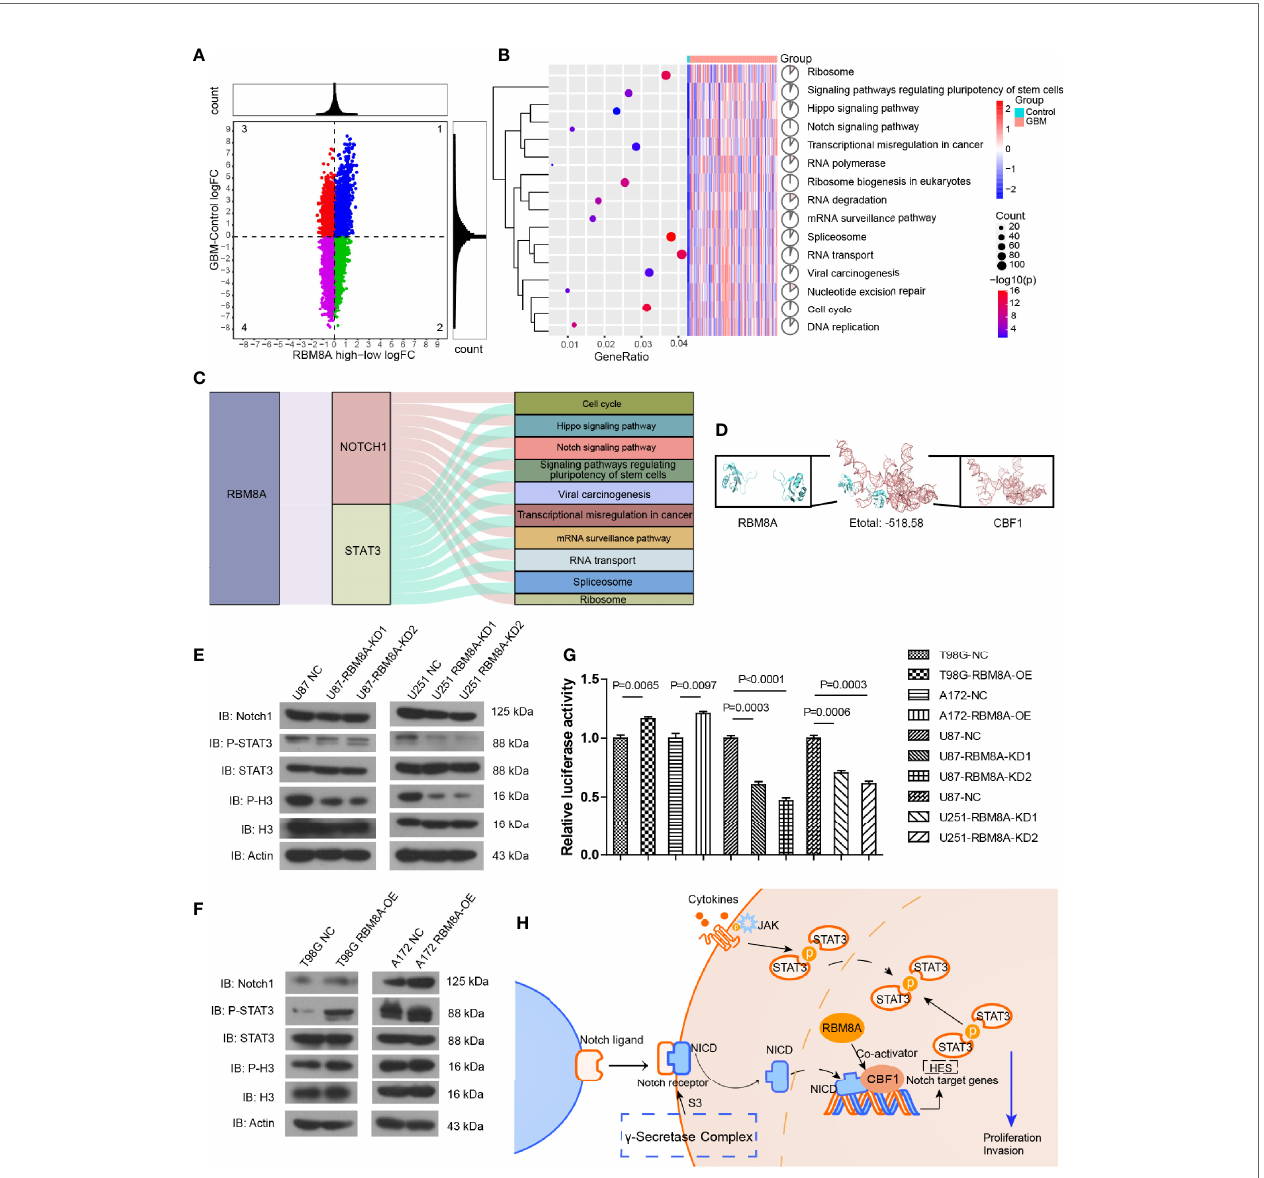
FIGURE 4 | Effects of RBM8A expression on the Notch/STAT3 pathway in GBM cells. (A) Quadrant plot. The genes in quadrant 2 were upregulated genes consistent with RBM8A expression. (B) Analysis of Kyoto Encyclopedia of Genes and Genomes (KEGG) pathway enrichment was performed on the consistently up-regulated genes. (C) RBM8A affects biological pathways by regulating Notch1 and STAT3. (D) Molecular docking of RBM8A and CBF1. (E) Western blot analysis of Notch1, phosphorylated STAT3 (p-STAT3), total STAT3 (STAT3), phosphorylated H3 (p-H3), total H3 (H3), and actin in U87-MG and U251-MG cells transformed with negative control (NC) lentivirus or with lentivirus encoding RBM8A-KD1 or -KD2. (F) Western blot analysis of the same proteins in A172 and T98G cells transformed with NC lentivirus or lentivirus encoding RBM8A (RBM8A-OE). (G) Luciferase reporter assay of RBM8A- induced activation of CBF1 in GBM cells. (H) RBM8A regulates the Notch/STAT3 signaling pathway by targeting CBF1, which may be a mechanism by which RBM8A contributes to GBM